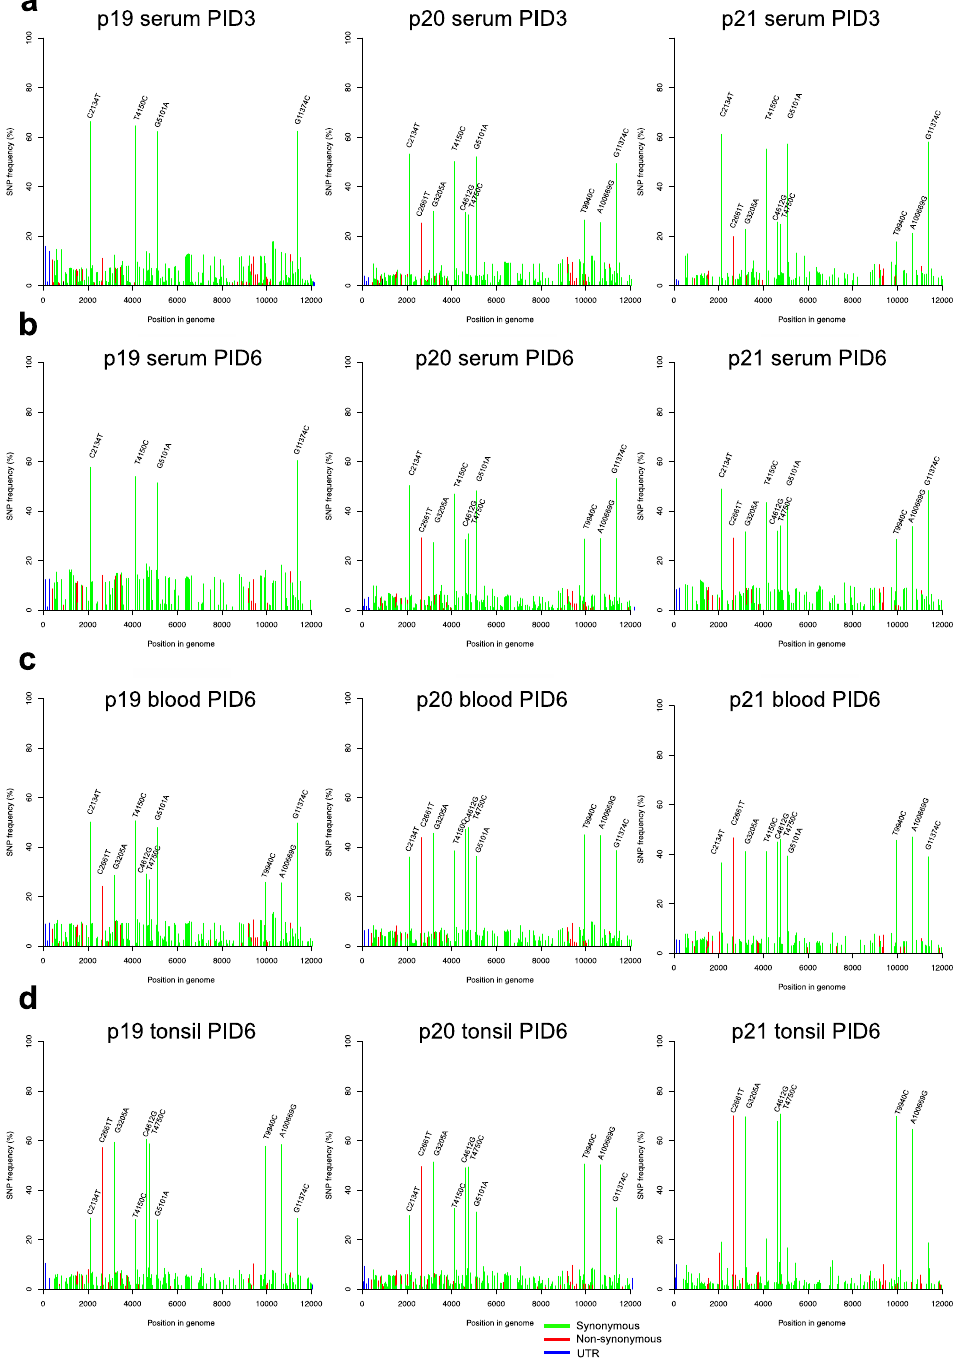
Figure 3. SNP frequency plots of the virus in the naïve pigs (p19, p20, and p21 respectively) following virus challenge. SNPs present at a frequency above 20% are indicated on each plot in the following samples: ( a ) serum (PID3), ( b ) serum (PID6), ( c ) blood (PID6), and ( d ) tonsils (PID6). The SNP frequency plots for serum (PID6) were determined directly from RNA, whereas the others were determined following RT-PCR. The red, green, and blue colours of the bars represent non-synonymous, synonymous, and untranslated region (UTR) mutations, respectively.